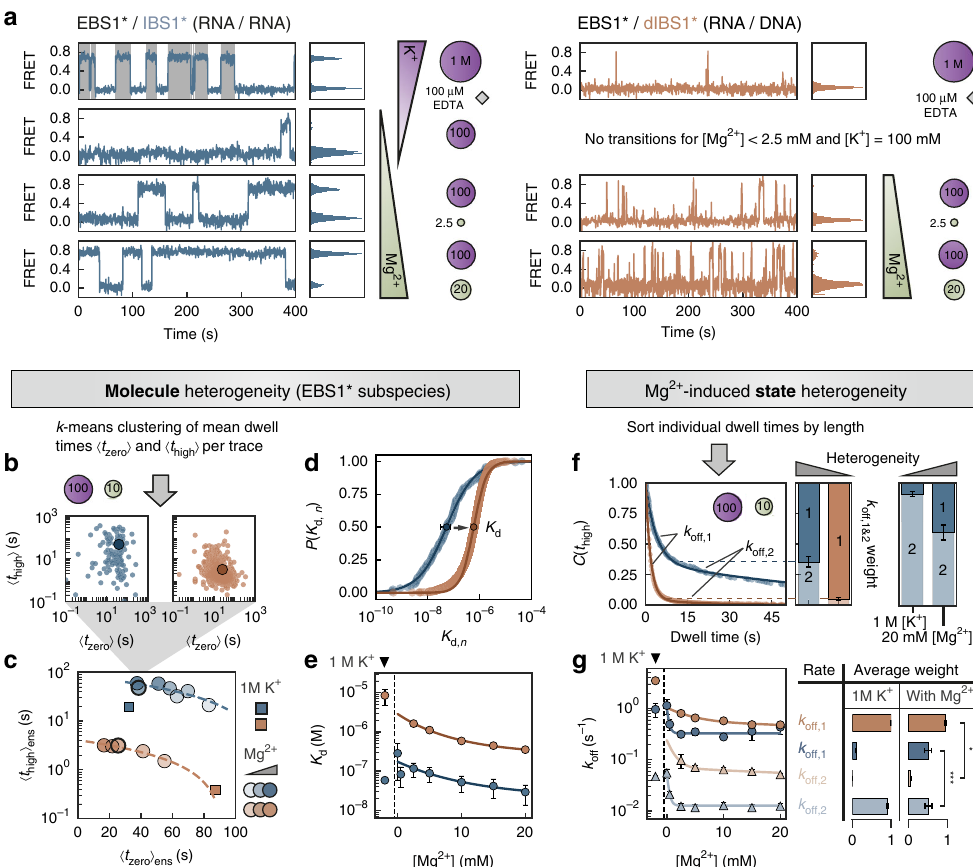
Fig. 2 Kinetic heterogeneity is tuned by Mg 2 + and the nucleic acid strand type. a Representative single-molecule traces of EBS1*/IBS1* (blue) and EBS1*/ dIBS1* (orange) displaying different residence times in the zero and high FRET state in response to gradual changes in the composition of the ionic environment. The traces are selected to re fl ect the overall histogram shown in Fig. 1f. The discretized state sequence is depicted by alternating backgrounds (white: zero FRET; gray: high FRET) for the top left trace and omitted elsewhere for clarity. Only dynamic molecules were used for the analysis. b The molecule-to-molecule variability is visualized by correlating the mean dwell times in the bound, 〈 t high 〉 , and unbound state, 〈 t zero 〉 , for every time trace. There are no distinct kinetic subspecies, but rather a single stretched cluster. Data is shown for 100 mM K + and 10 mM Mg 2 + . c The cluster center is calculated by k -means and depicted as a circle in different shades of blue or orange for every Mg 2 + concentration (10 mM Mg 2 + is highlighted with a thick, black edge). Contact formation under high ionic strength (1 M K + ) in the absence of Mg 2 + (100 μ M EDTA) is indicated by a blue or orange square. d Cumulative K d, n histograms (10 mM Mg 2 + ) are fi tted to a logistic function (Supplementary Eq. 13). e Stability constants of EBS1*/IBS1* and EBS1/ dIBS1 as a function of Mg 2 + are quanti fi ed by the transition point, K d , from fi ts in c . Error bars are drawn as mean ± 2 s.d. of 100 bootstrap samples. f Heterogeneity within the bound state is evaluated by computing cumulative dwell time histograms of the bound state. The presence of multiple decays is a characteristic of kinetic heterogeneity. The weighting factors (mean ± s.d.) of the dissociation rate coef fi cients k off,1 and k off,2 are indicated alongside the decay. The ion dependence of the prefactor is displayed on the right for EBS1*/IBS1*. g Rate coef fi cients and average weighting factors (mean ± s.d.) over the whole Mg 2 + titration. The star (*) indicates the degree of heterogeneity. The latter is largest if the rate coef fi cients are far apart and equally populated (weighting factor ≈ 0.5). Source data are provided as a Source Data fi